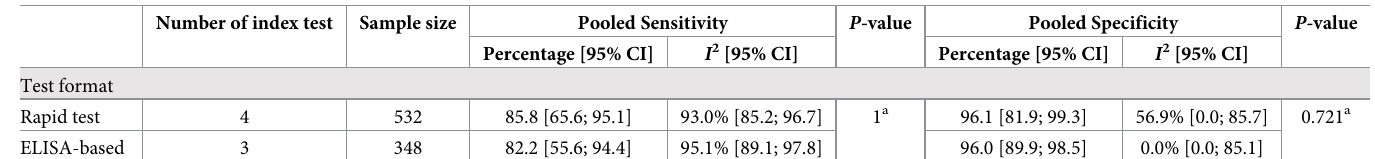
Table 6. Analysis for antigen detection